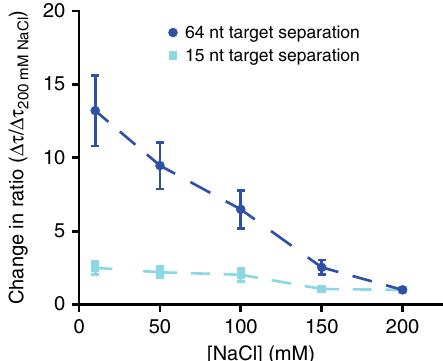
Fig. 6 Argonaute target search is characterized by sliding and intersegmental transfer. The relative change in shuttling time of two constructs from Fig. 3, 64 nt separation (dark blue circles) and 15 nt separation (light blue squares), normalized against Δ τ shuttle at 200 mM NaCl. Errors of the ratio were determined through bootstrapping 10 5 times the ratio of Δ τ shuttle / Δ τ 200 mMNaCl . Source data are provided as a Source shuttle Data fi